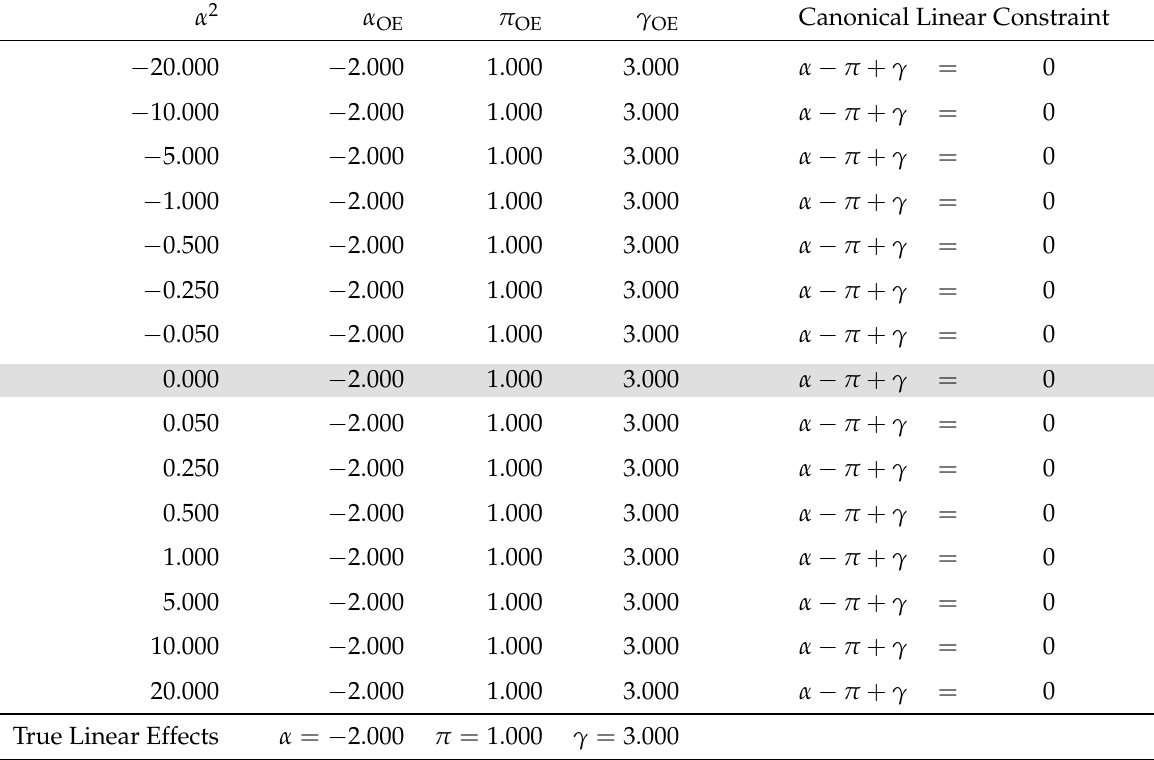
Table 11: Robustness of the OE to age